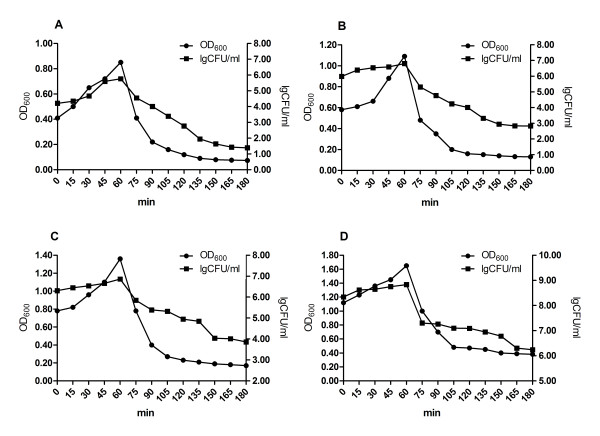
The lysis curve of E. coli DH5α cells containing pBV-Me. The lysis curve of DH5α containing pBV-mE at (A) OD600 = 0.4, (B) OD600 = 0.6, (C) OD600 = 0.8, (D) OD600 = 1.0